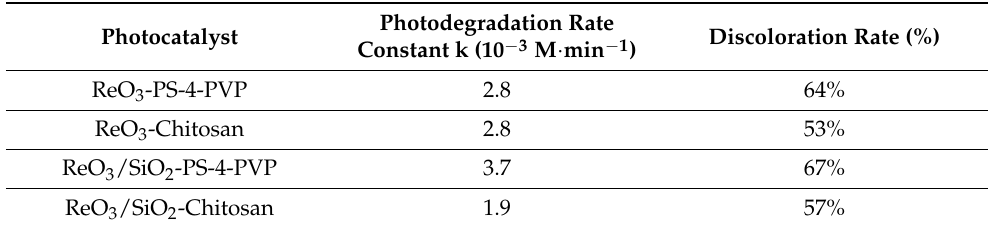
Table 4. Kinetic data for the photodegradation process of MB with ReO 3 and ReO 3 /SiO 2 . Adapted from reference [62].